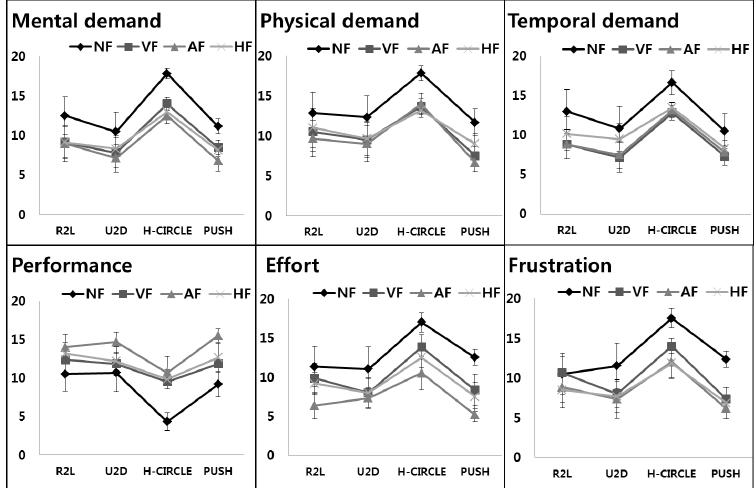
Figure 22. The participants’ responses to the NASA-Task Load Index (TLX) questionnaire. In all but performance, a lower value is